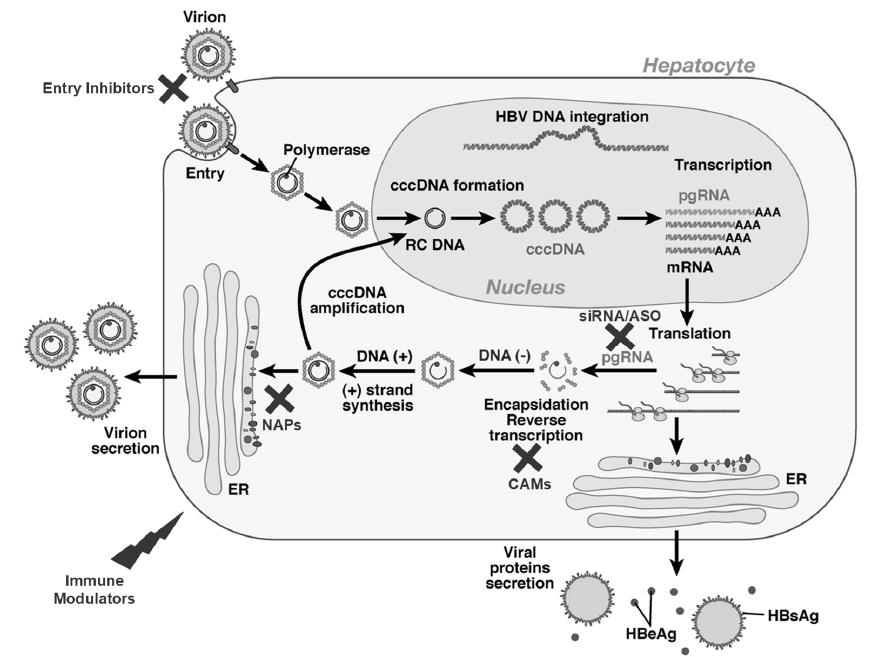
Figure 1. HBV replication cycle and potential antiviral targets. cccDNA: covalently closed circular DNA; RC DNA: relaxed circular DNA; pgRNA: pregenomic RNA; mRNA: messenger RNA; ER: endoplasmic reticulum; HBsAg: Hepatitis B surface antigen; HBeAg: Hepatitis B e antigen; CAMs: capsid assembly modulators; siRNA: small interfering RNA; ASO: antisense nucleotide; NAPs: nucleic acid polymers. Adapted from Zoulim F, et al. Gastroenterology 2009;137:1593-1608 Table 1. Overview of new HBV compounds under development.